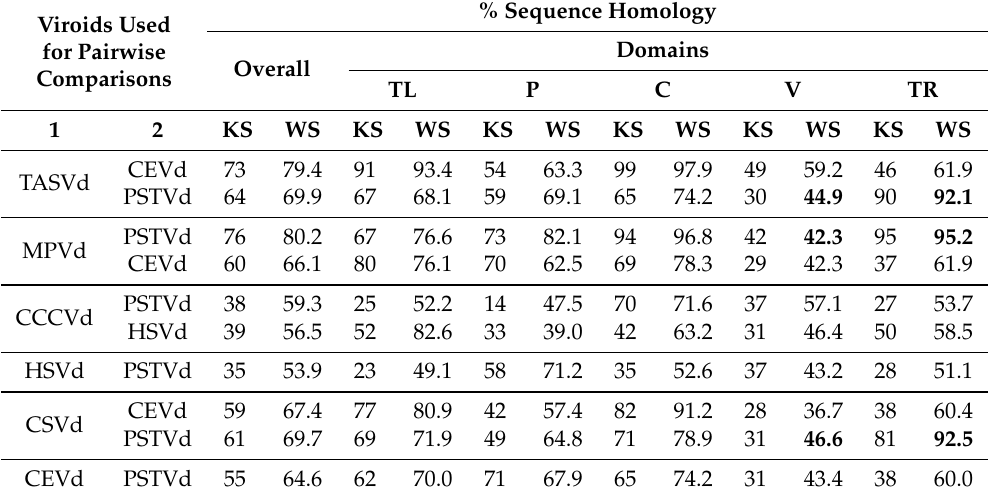
Table 2. Sequence homology between the domains of different viroids. Values in columns labeled “KS” are copied from Keese and Symons (1987) [52]. The table in Keese and Symons (1985) [11] only differs by the missing values for the V and TR domains of HSVd. Pairwise sequence identity (PSI) values in columns labeled “WS” are calculated on basis of a MAFFT X-INS- I alignment with options --maxiterate 1000 and --retree 100 . Bold values in columns V and TR point to viroid pairs with large differences in the PSI values of these